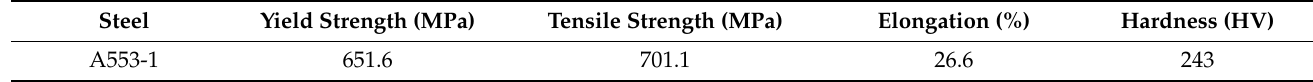
Table 2. Mechanical properties of steels